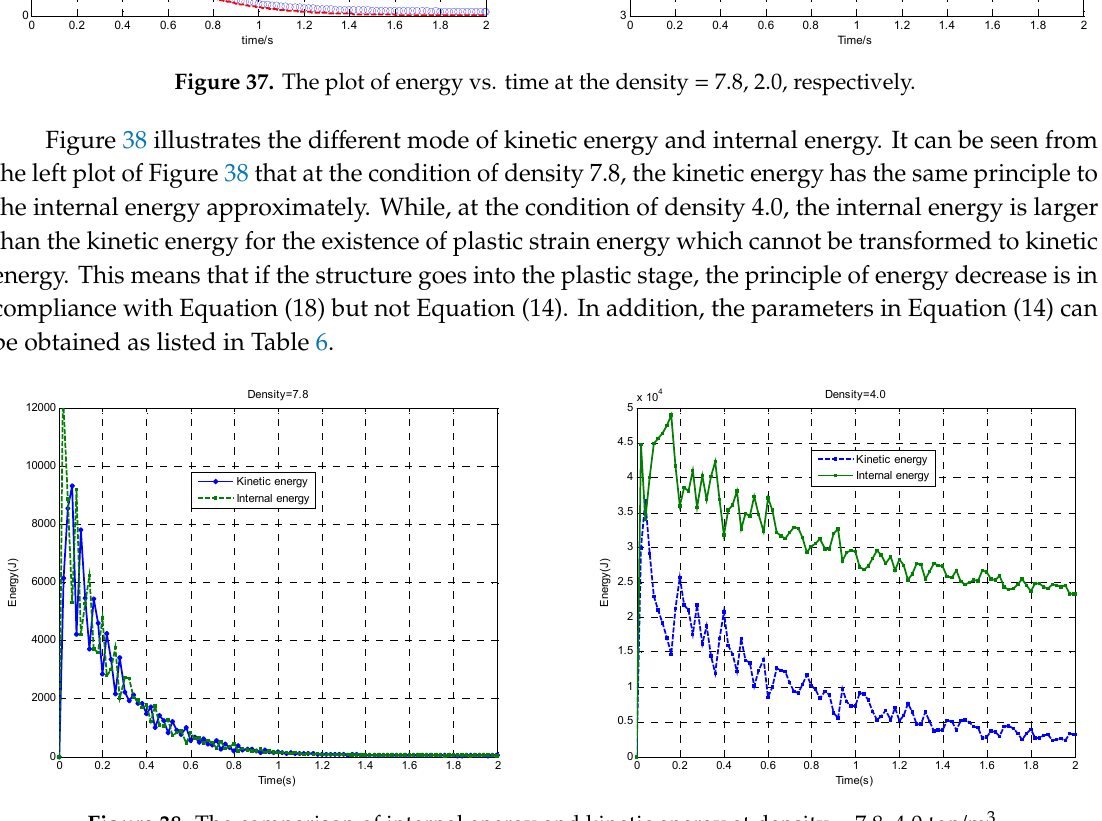
υ f = 210 MPa, = 0.23, y